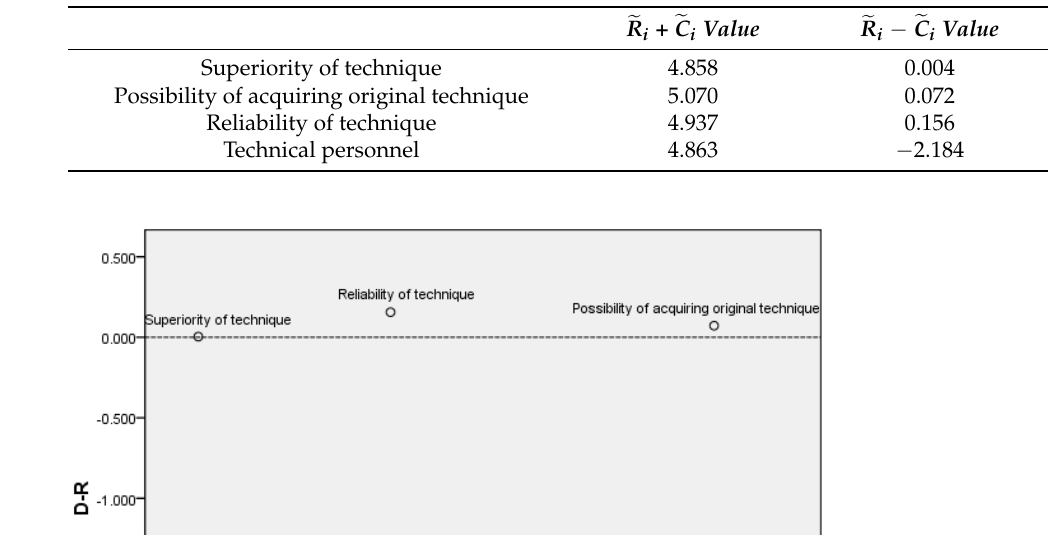
 def def − value and ( (cid:101) R i − (cid:101) C i ) value of impacts of the three criteria of the Table 6. The sum ( (cid:101) R i + (cid:101) C i ) Table 6. The sum and C value of impacts of the three criteria technological ability. of the technological ability.